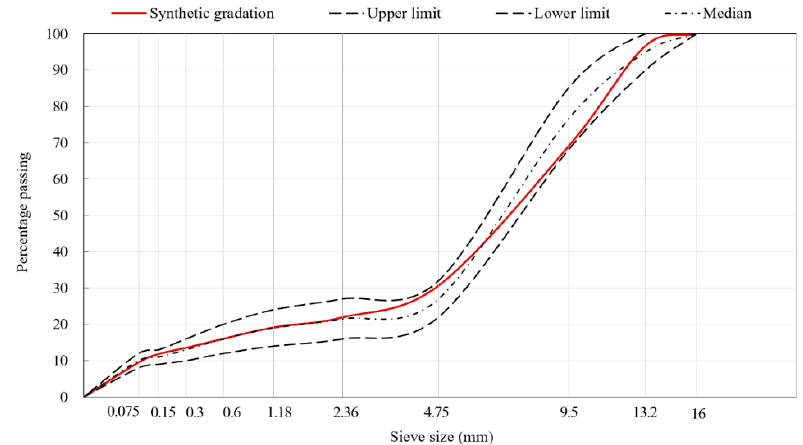
Figure 1. Aggregate grading curves of the SMA13 asphalt mixture.